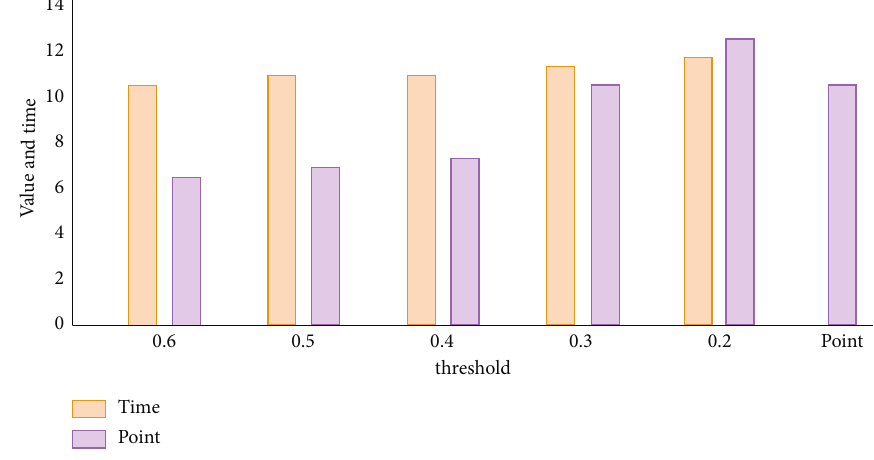
Figure 8: Statistics of class grammar evaluation